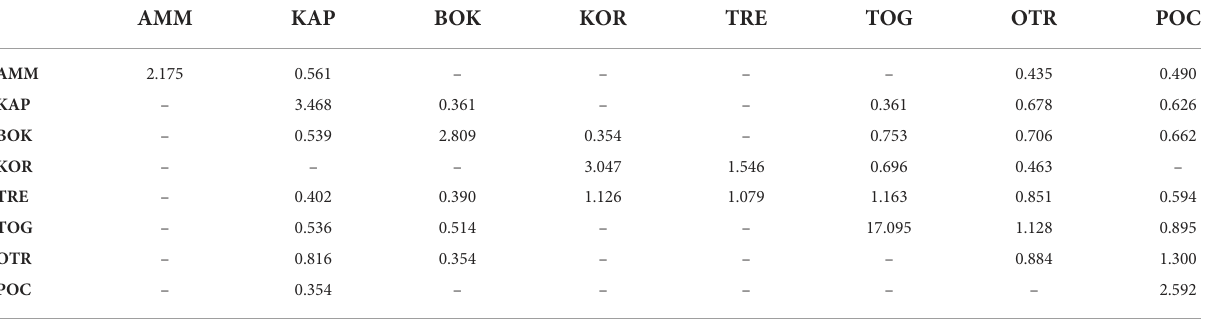
TABLE 7 Connectivity persistence for Pachygrapsus